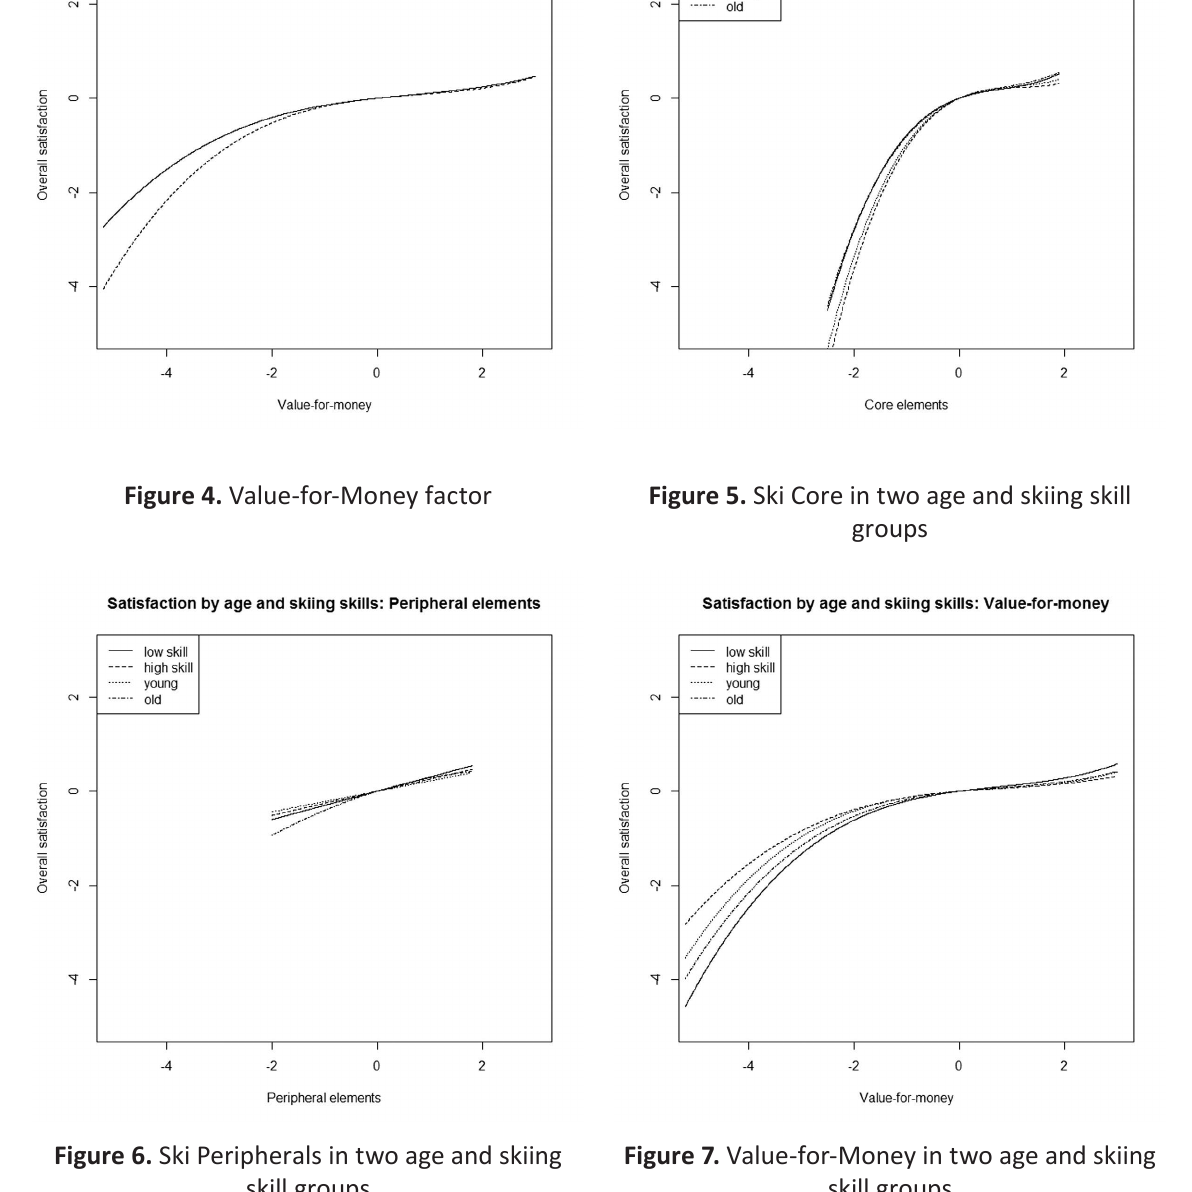
Figure 7. Value-for-Money in two age and skiing skill